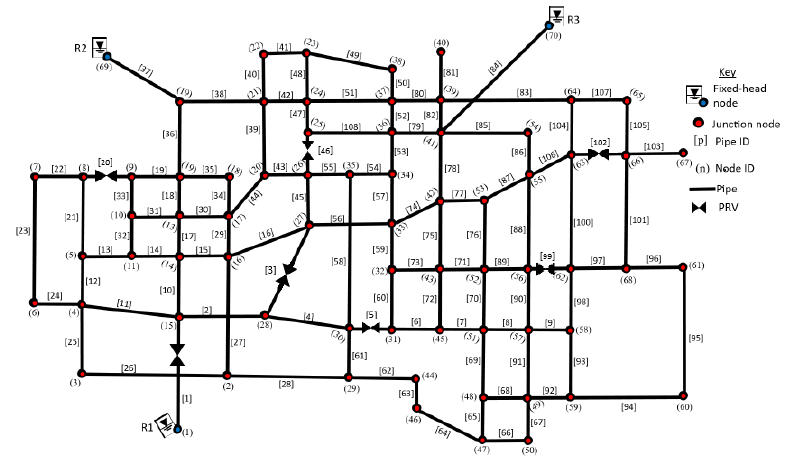
Figure 5. Case study